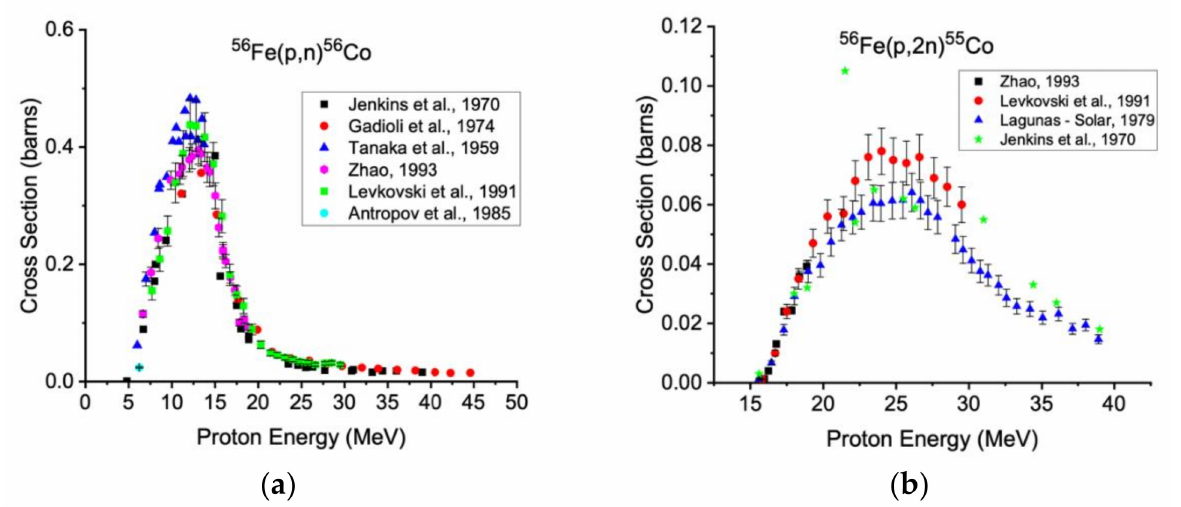
Figure 4. Measured excitation functions for 56 Fe(p,n) 56 Co ( a ) and 56 Fe(p,2n) 55 Co ( b ) [32,33,41–45]. These data are in agreement with measured data for production of cobalt-56 up to the threshold of the 57 Fe(p,2n) 56 Co reaction and for production of cobalt-55 up to the threshold of the 57 Fe(p,3n) 55 Co reaction using natural Fe targets